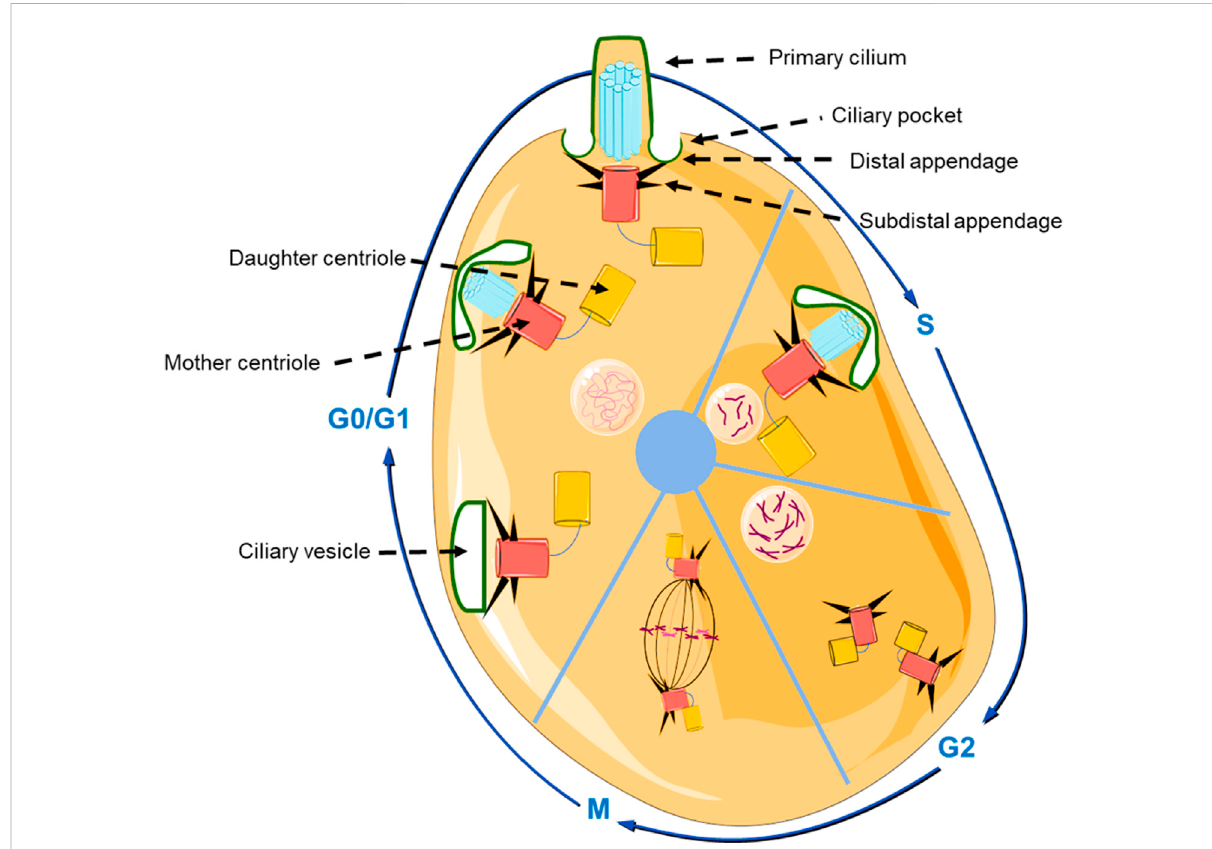
FIGURE 2 Schematic representation of the structure of the primary cilium, and the relationship between cell cycle and primary ciliogenesis. In the beginning of G0/G1 phase, the centrosome moves beneath the cell membrane and subsequently initiates ciliogenesis and gradually forms the primary cilium. In S phase and G2 phase, primary cilium is degraded, and the centrioles are duplicated and prepare to transform into the mitotic spindle pole in the M phase (The graphic components of the fi gure were provided by